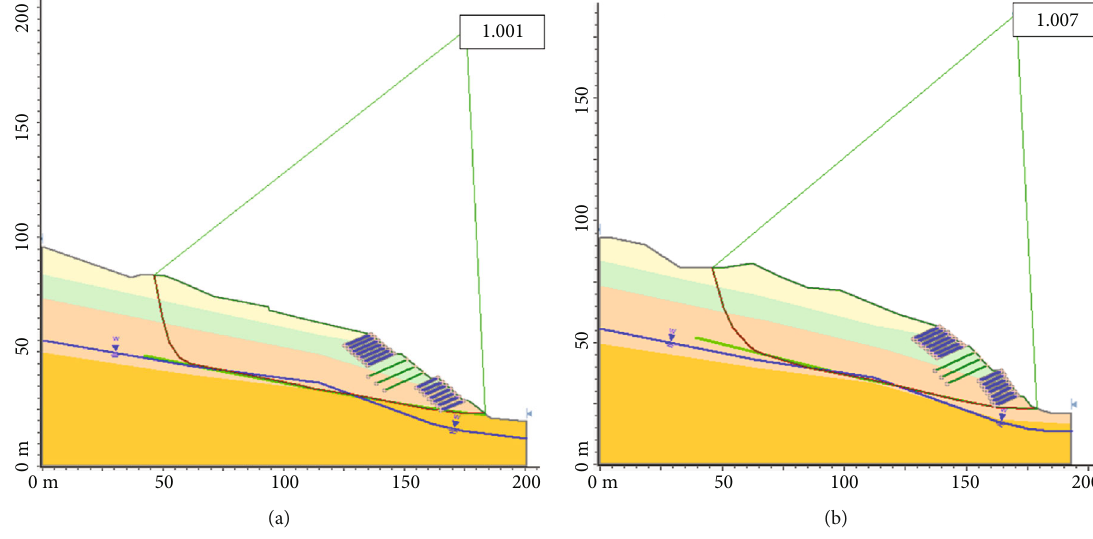
Figure 8: Calculation result of SLIDE: (a) section a1-a1 ′ ; (b) section K40 + 640 : 0